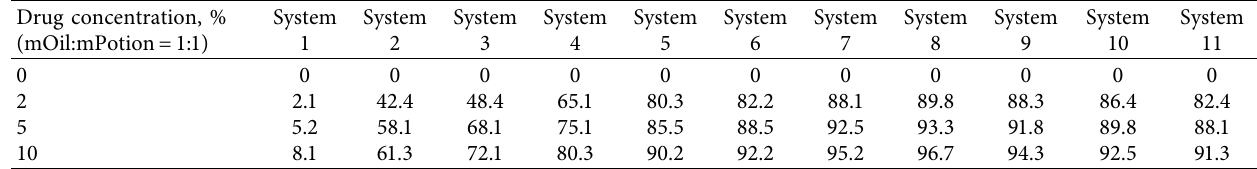
Table 3: The effect of the compound of reducing viscosity and inhibiting wax on reducing